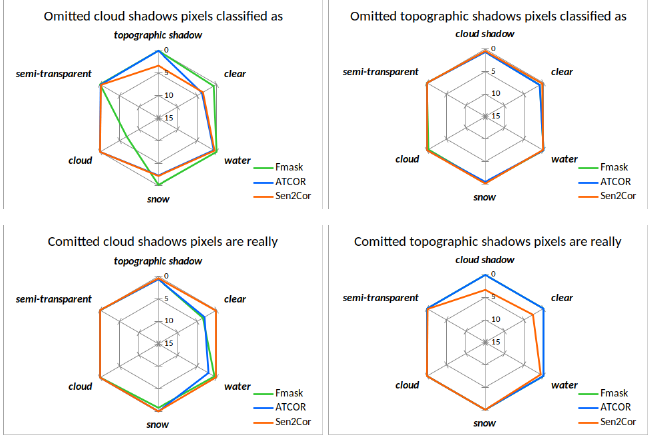
Figure 13. Omission and commission per Class for difference area for shadow classes cloud shadows and topographic